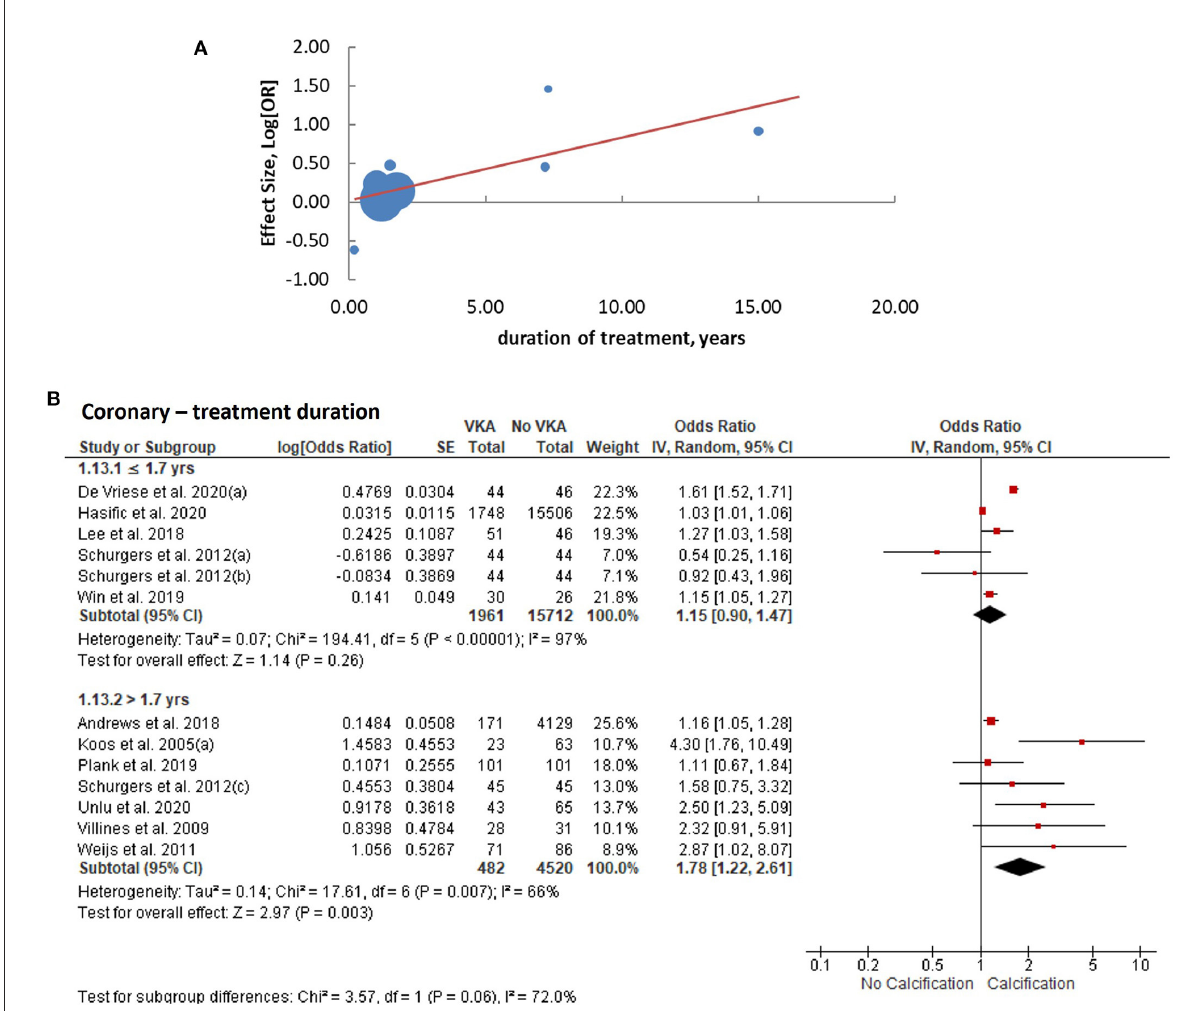
FIGURE4 Analysis of coronary arterial calcification according to the duration of VKA treatment. (A) meta-regression of the effect sizes—less or equal vs. more than the median duration; (B) subgroup analysis based on the duration of